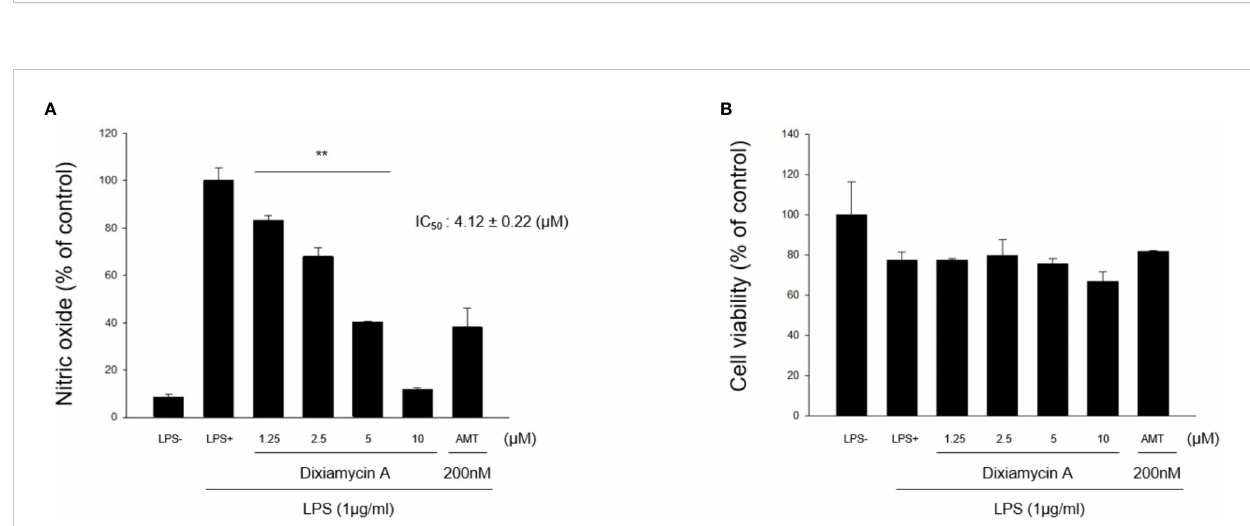
FIGURE 8 Effect of dixiamycin A (3) on LPS-stimulated NO production in macrophage cells. (A) RAW 264.7 cells were pre-treated with dixiamycin A (1.25, 2.5, 5, and 10 µM) for 1 h and then stimulated with LPS (1 µg/mL) for 20 (h) The supernatant from each well was collected to determine the degree of NO production using the Griess reaction. (B) The cell viability was determined using the MTT assay. Data are expressed as mean ± SD (N=3) based on data recorded from three independent experiments. ** p <.01 vs. the LPS-treated control